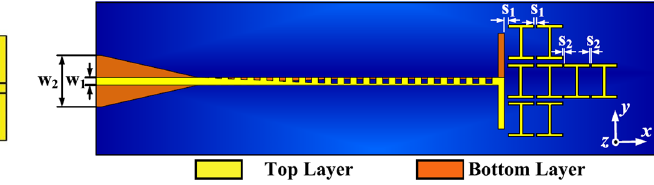
Fig. 7. An end- fi re SSPP antenna based on electric